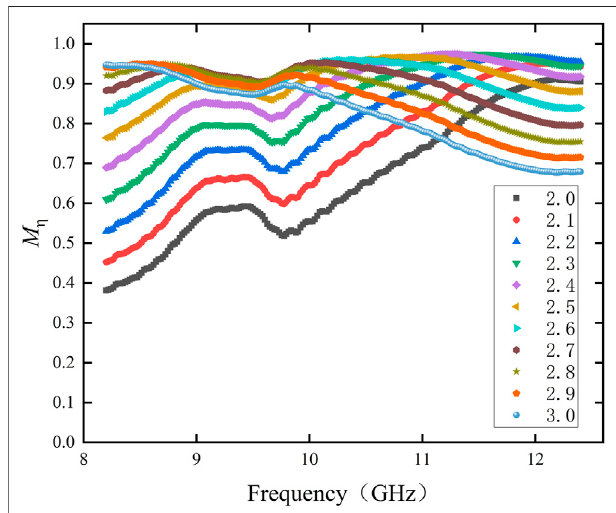
FIGURE 10 | Impedance matching coef fi cient graph of samples S2 for 2.0 – 3.0 mm. The graph shows the wave impedance matching factor ( M η ) for sample